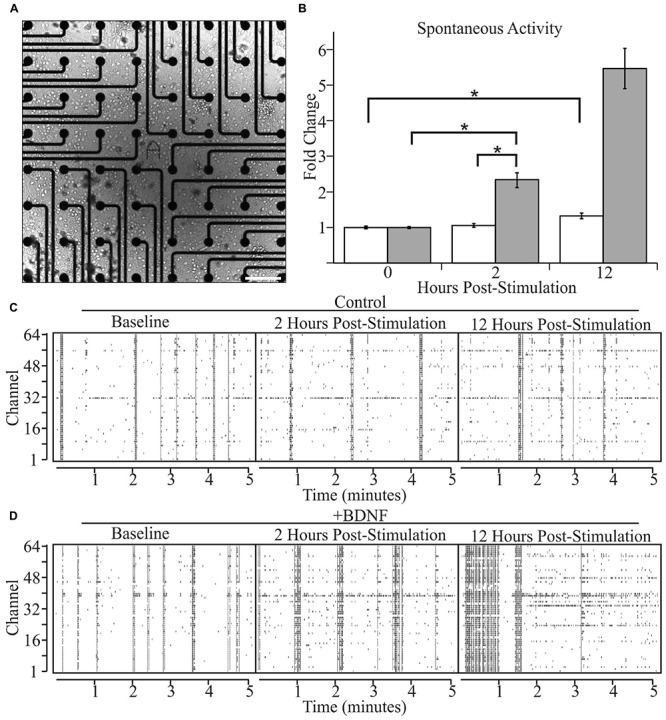
Brain-derived neurotrophic factor increases spontaneous activity in cultured neurons as determined by multi-electrode arrays. (A) A bright-field image of a representative cortical culture at 12 DIV on a multi-electrode array. Scale bar equals 200 μm. (B) Array-wide spike densities at the indicated time are displayed as fold change relative to the pre-treatment baseline period (0 H) before the addition of vehicle (white bars) or 5 ng/ml BDNF (gray bars) for 12 h. N = 36 (12 recordings per time point from three pairs of independent sister cultures). All recording were made during a 2 h window ending at the indicated time. Error bars represent SEM. ∗p < 0.05 assessed with an unpaired Student’s T-test comparing the means of vehicle and BDNF treated neurons. (C,D) Raster plots from vehicle-treated (C) and BDNF-treated (D) sister cultures showing 5 min of representative electrode activity binned into 1 s intervals. Black tick marks indicate action potential activity at a given electrode. The vertical axis denotes the MEA channel from which the recordings were made. The left plots are from the pre-treatment baseline. The middle plots are from 2 h post-treatment. The right plots are from 12 h post-treatment.